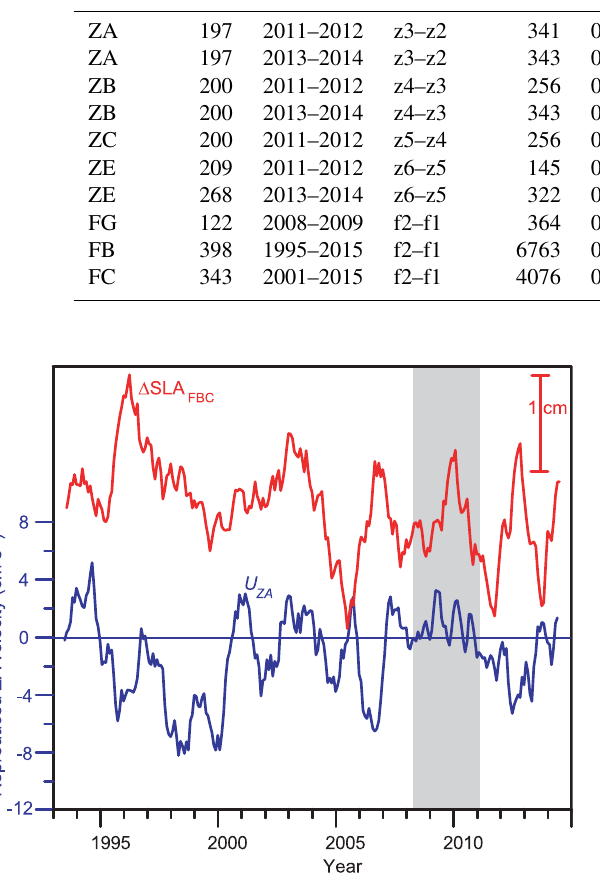
Figure 5. Annually (13 months) filtered values of reproduced east- ward velocity at 200m at ZA ( U ZA , blue) and difference in SLA values between f1 and f2 (f2–f1: (cid:49) SLA FBC , red). The grey area in- dicates the period of ferry-based ADCP measurements by Rossby and Flagg